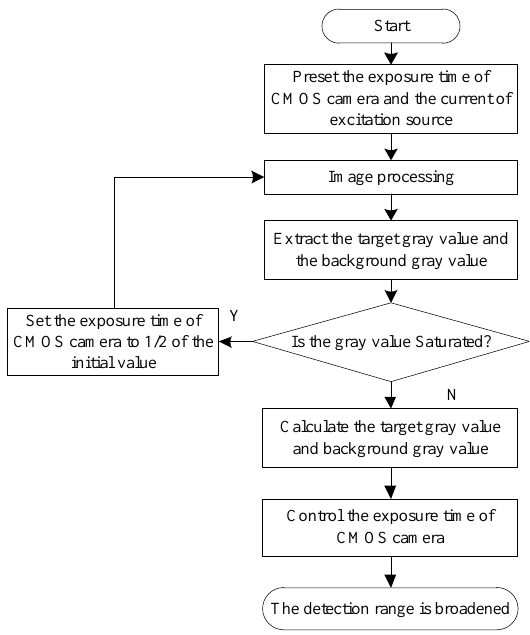
Figure 6. Flowchart of automatic range adjustment.